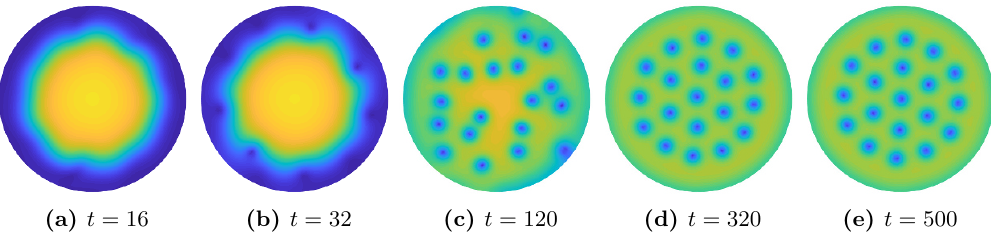
Figure 5. Condensates as functions of space coordinates when the lattice consists 19 vortices. In this plot, we choose (cid:10) = 0 : 22.